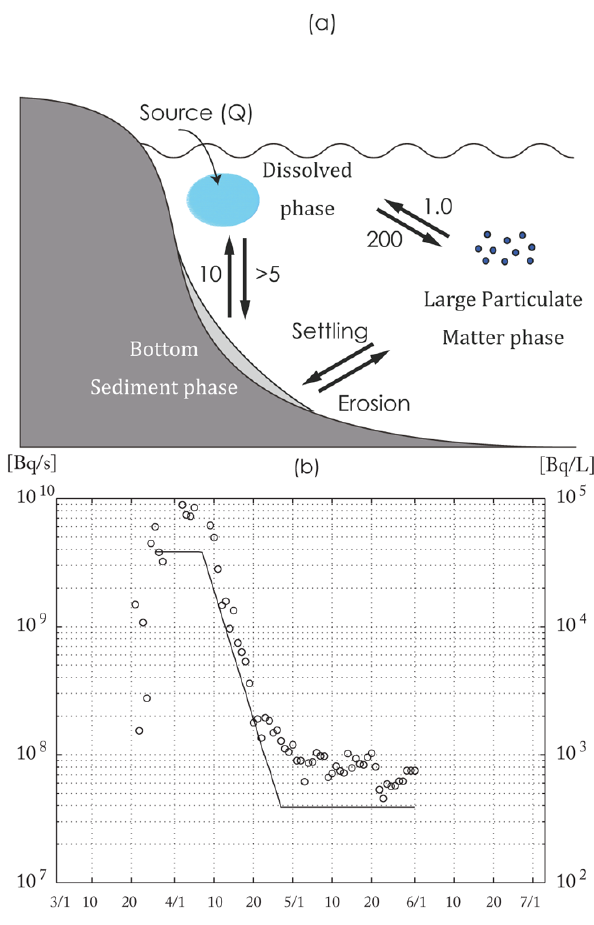
Fig. 3. (a) A schematic showing the three phases solved by the particle-tracking model along with the timescale of the phase trans- fer in [days]. Radionuclides are first introduced in dissolved phase. (b) Time series of the 137 Cs source term based on Tsumune et al. (2012) are shown in a black solid line ([Bqs − 1 ], left axis). Observed concentrations at the outlet of Dai-ichi FNPP (TEPCO, 2011) are shown in a black circles ([BqL − 1 ], right